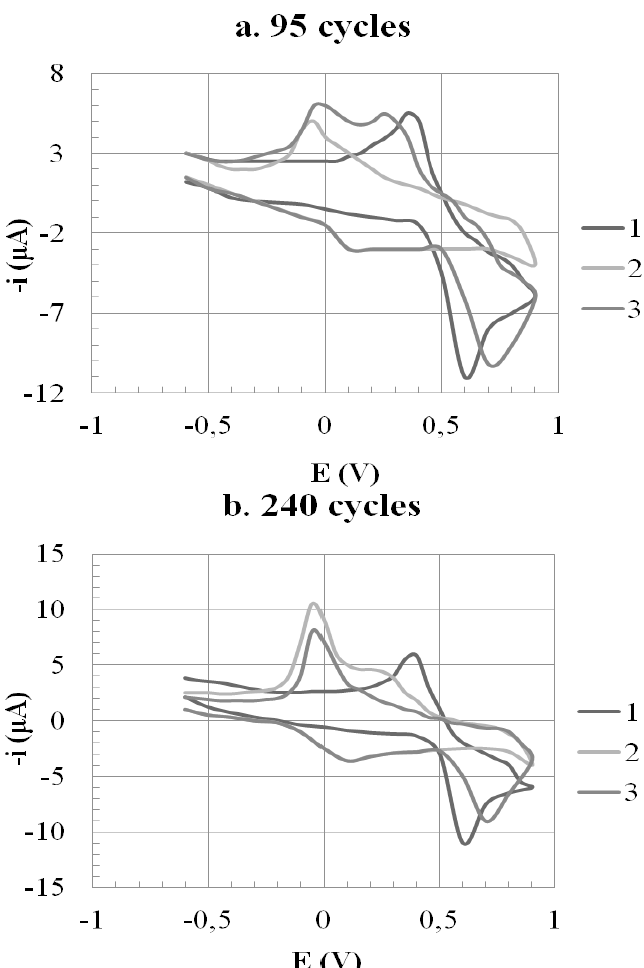
Figure 11. Cyclic voltammograms of (1) 5×10 -4 mol L -1 pyrocatechin + 1 mol L -1 HClO GCE, (3) 5×10 -4 mol L -1 pyrocatechin + 1 mol L -1 HClO